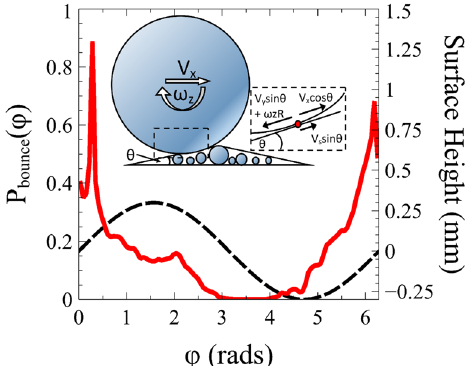
Figure 5. Histogram of the phase of ball bounces (left) relative to the surface height (right). The probability of a collision during the upwards phase of the surface is strongly enhanced. Inset: Schematic showing the asymmetry due to surface structure. As v x increases, the relative probability of hitting ‘upwards’ sloping collections of particles increases. The contributions to the relative contact velocity of the ball–surface contact when components are taken parallel to the local surface geometry. (Figure prepared using Microsoft Publisher and Veusz https ://veusz .githu